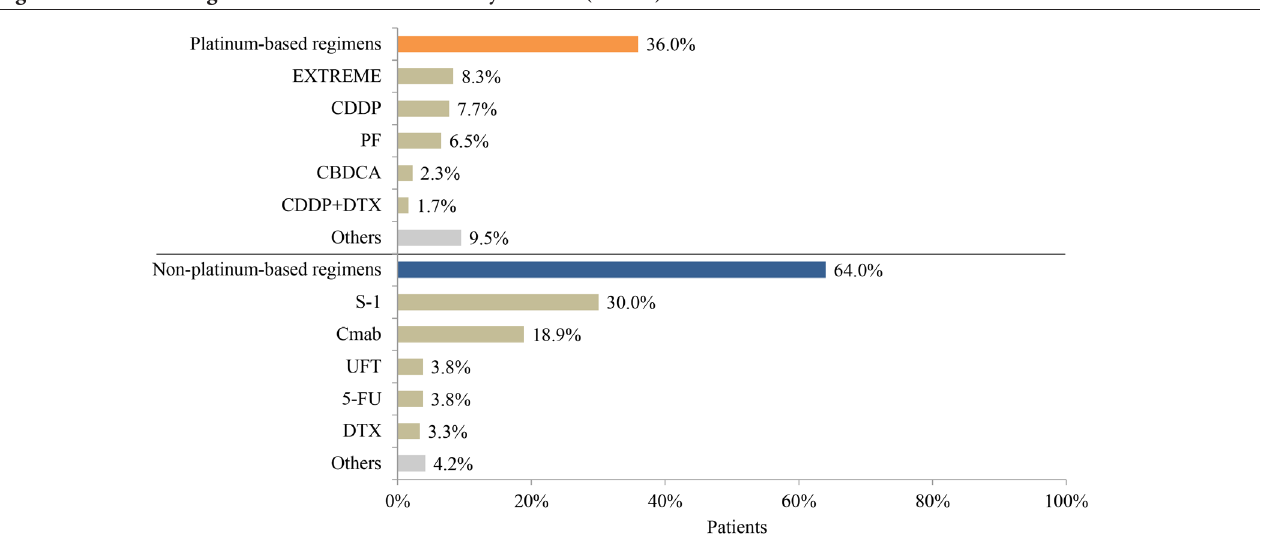
Figure 6. Treatment Regimens for Platinum-Refractory Patients